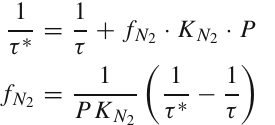
( ∼ 1 / W sc | 2nd ) are corrected for the effect by multiplying by the factor (e.g.